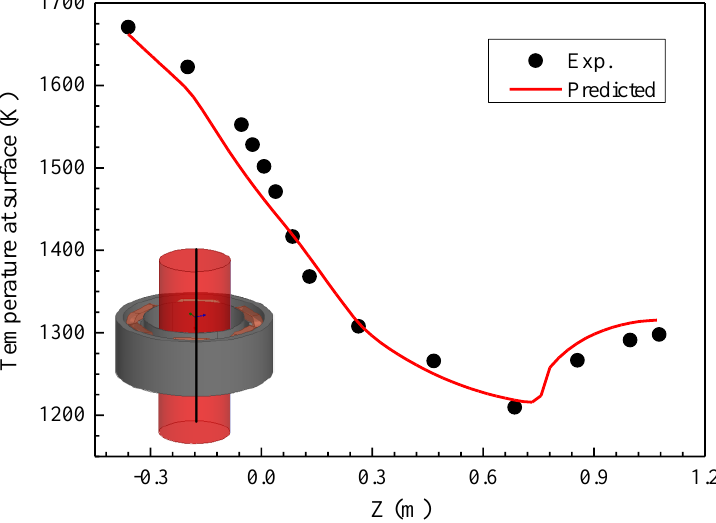
Figure 3. Comparison of the predicted and measured temperature along the surface line of Y=350 mm.